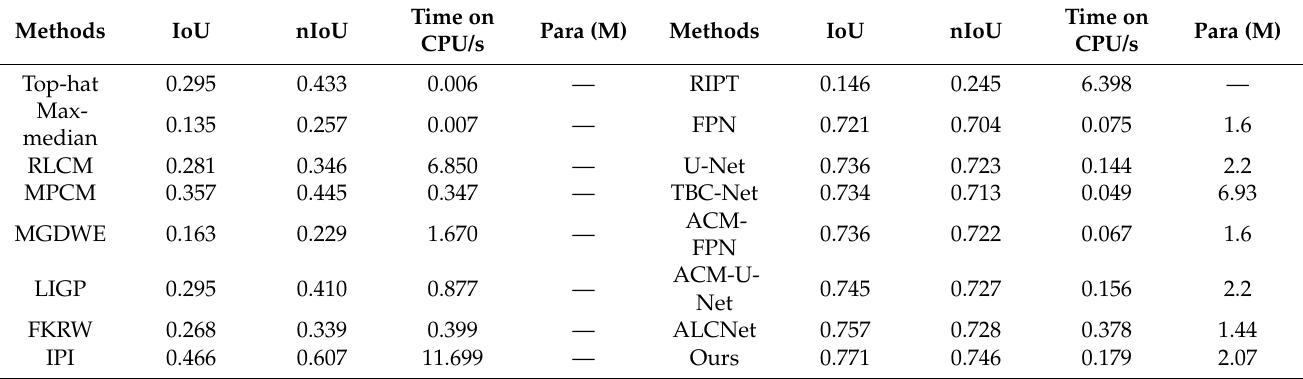
Table 3. Comparison with state-of-the-art methods on IoU and